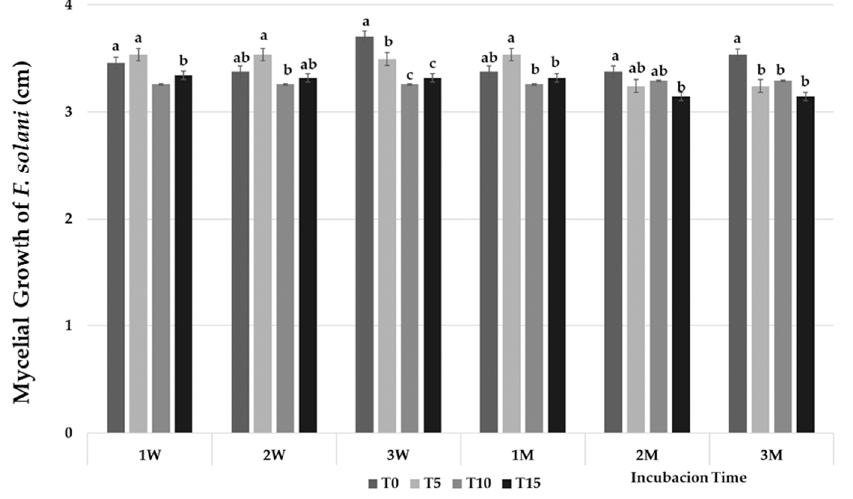
Figure 5. Effect of the cell-free filtrate of P. variotii culture on mycelial growth of F. solani . Incubation time: 1, 2, and 3 weeks (W); 1, 2, and 3 months (M). T0, T5, T10, T15: % extracts incorporated and mixed with cooled PDA at 0 (Control), 5, 10, and 15% ( v/v ). Means with the same letter are not significantly different (least significant difference test) according to an analysis of variance.